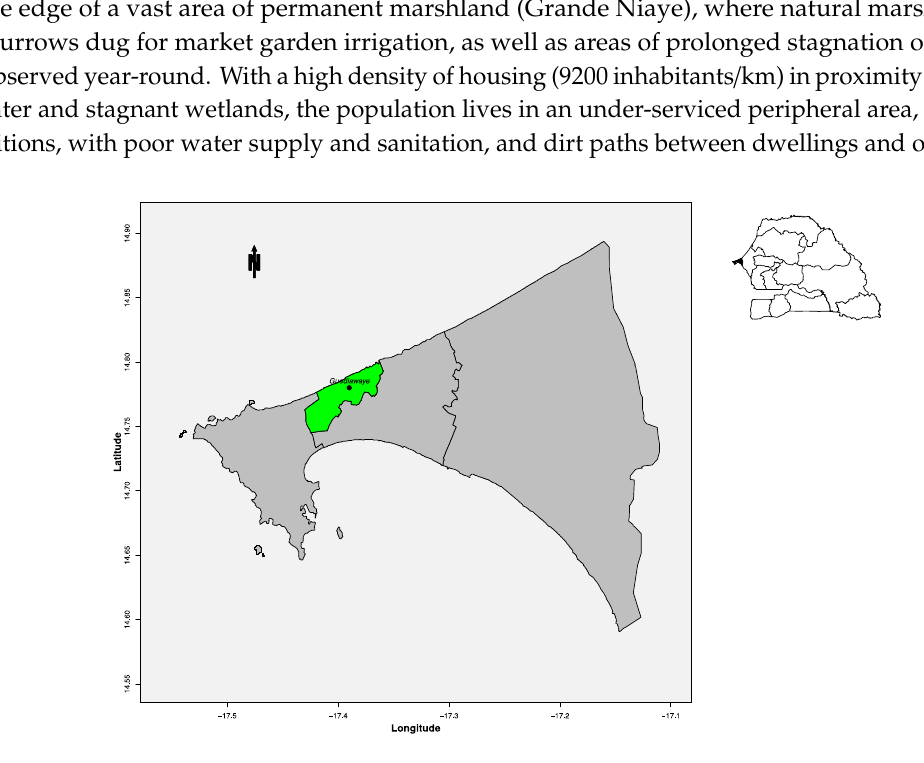
Figure 1. Map showing the area of study .